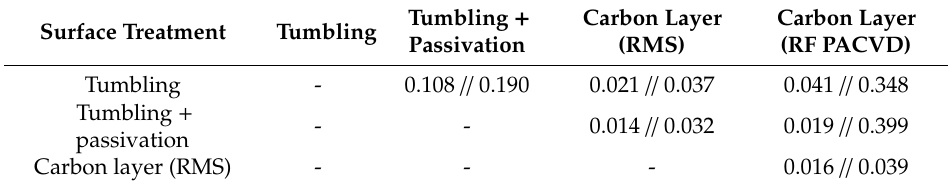
Table 8. Statistical analysis (p-values) of the contact angle measurements for X39Cr13 //